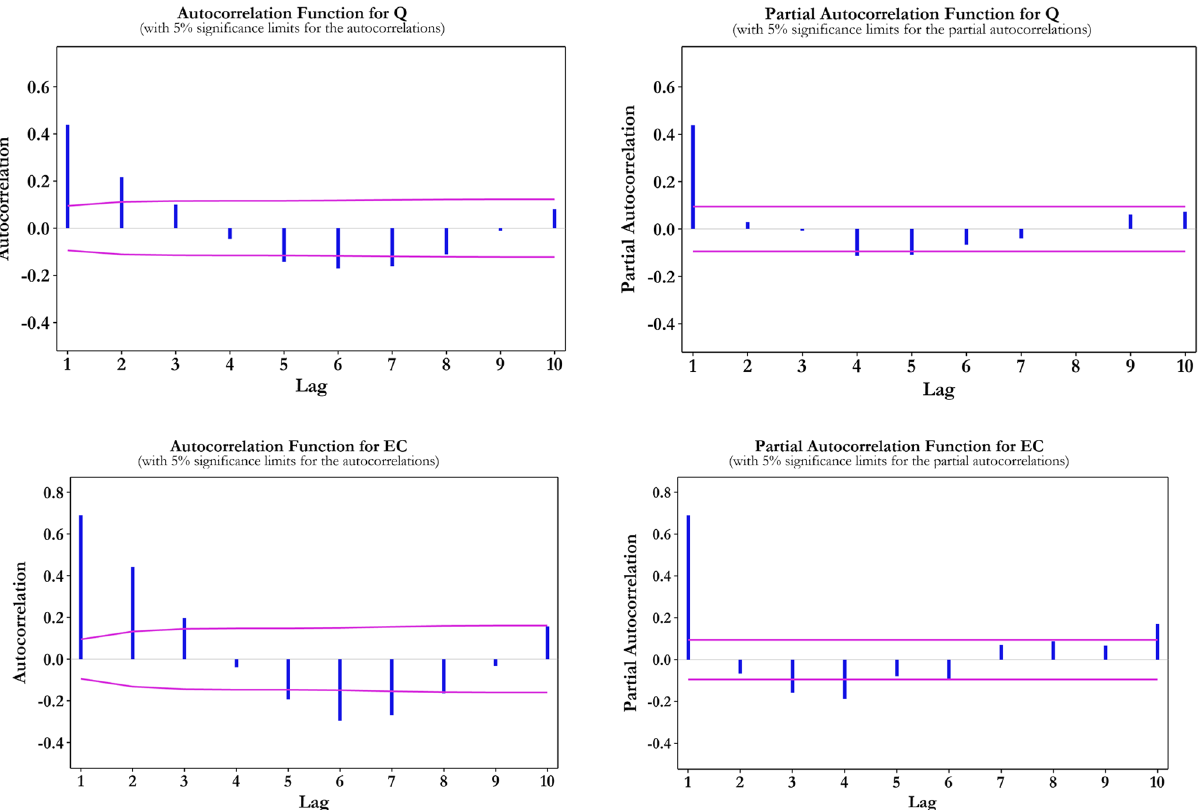
Figure 5. ACF and PACF of input and target datasets.